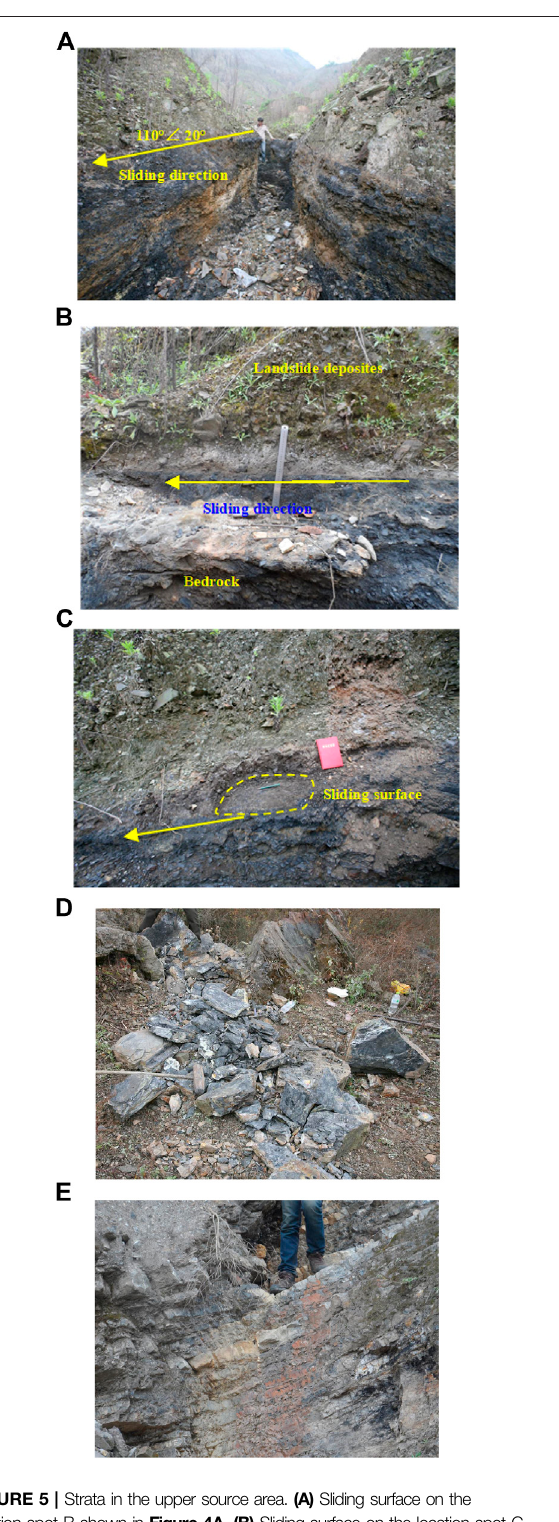
Frontiers in Earth Science |